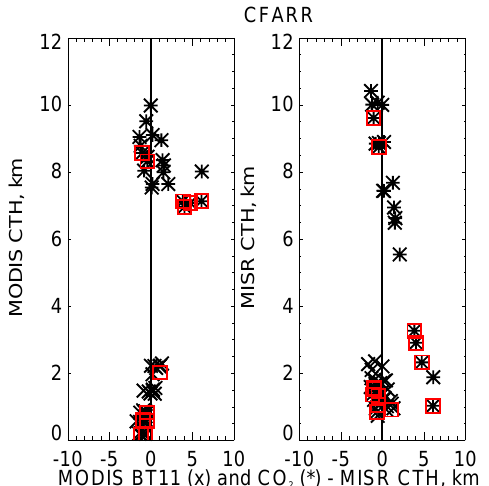
Fig. 7. MODIS (left) and MISR (right) cloud-top heights vs. the difference between MODIS and MISR cloud-top heights for all cases found at CFARR, with BT11 cases marked as (x), CO 2 -slicing as (*) and cases with a radar retrieval and a multilayer situations